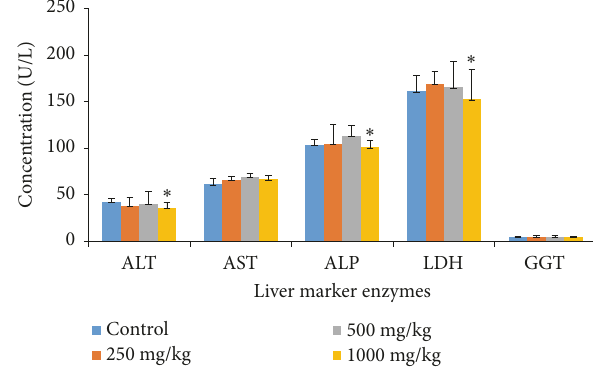
Figure 1: The effects of pomelo extract on body weight (g) gain. Results are expressed as mean ± SD. (n=8). Nonsignificant changes were found when all treatment groups were compared against the control group (p < 0.05) as determined using one-way ANOVA followed by Dunnett’s multiple comparison tests.